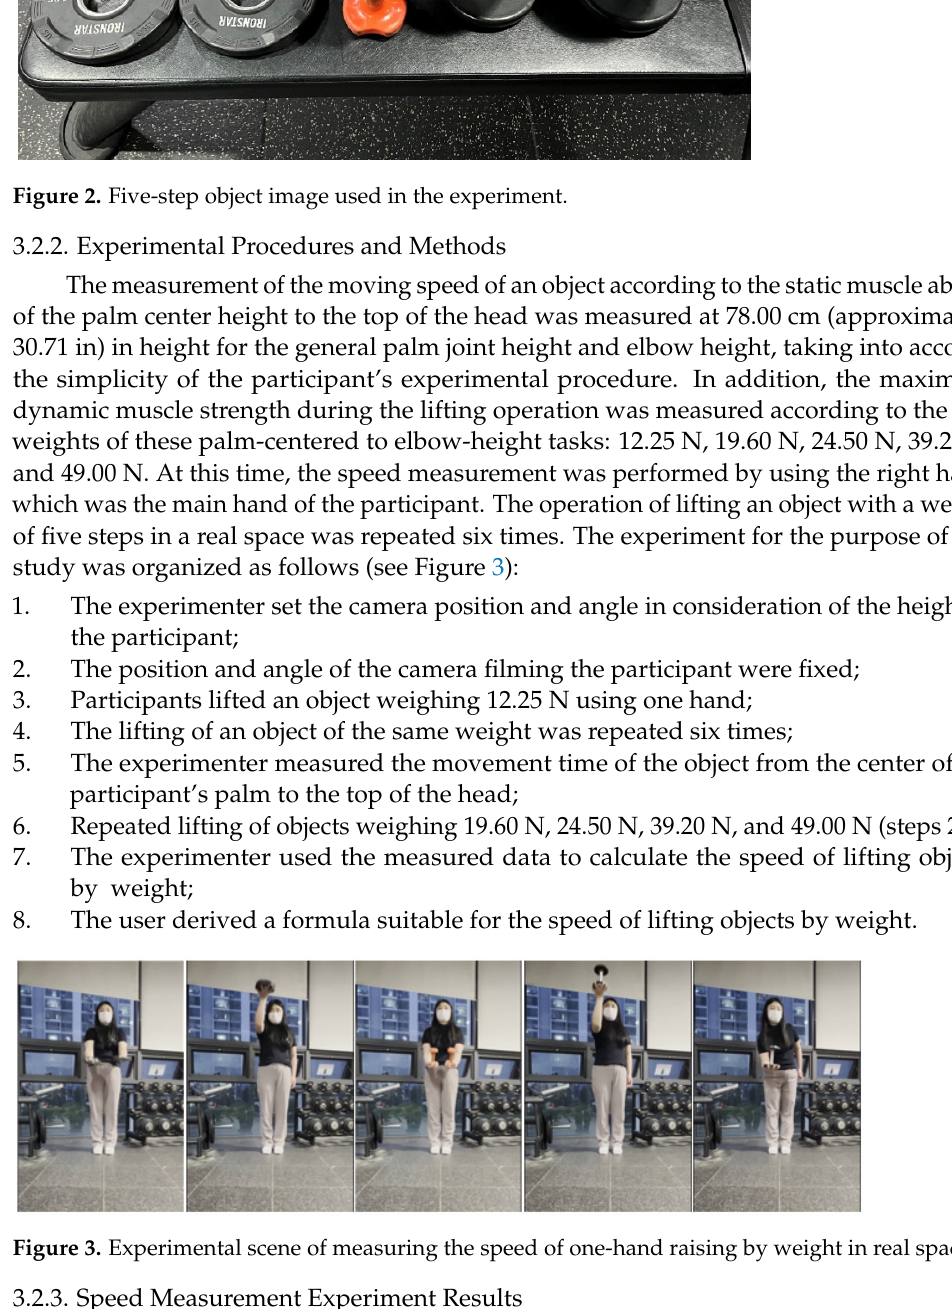
Figure 4. Experimental results for measuring the lifting speed of objects by weight in real space (from 12.25 N to 49 N). 3.3. Exclude Inertia If only the weight due to gravity and the muscle force, which is the force to lift an object, are applied to the VR environment, maximum inertia occurs, and it takes a rela- tively long time for the object to stop, causing the virtual object to shake. Therefore, we removed the falling inertia that occurred at the moment of holding the object to reduce the maximum inertia of the object. When a tracked 3D hand model passes through a weighted virtual object in a VR environment, the tracked 3D hand model has a force F to lift the object at the same time as it passes so that the virtual object does not fall to the floor and moves the virtual object using the Y-axis position value of the tracked hand. 3.4. Hand Tracking In this study, the controller was not used for the natural user interface (NUI) for nat- ural interaction. Hand tracking using a camera in a VR headset was used for interaction. Hand tracking using the Oculus Interaction Software Development Kit (SDK) can im- prove user immersion in a VR environment. 4. Design and System Implementation of Simulated Content In this chapter, we describe the construction of a virtual environment for virtual ob- ject weight recognition algorithm-based simulation content and the method of hand